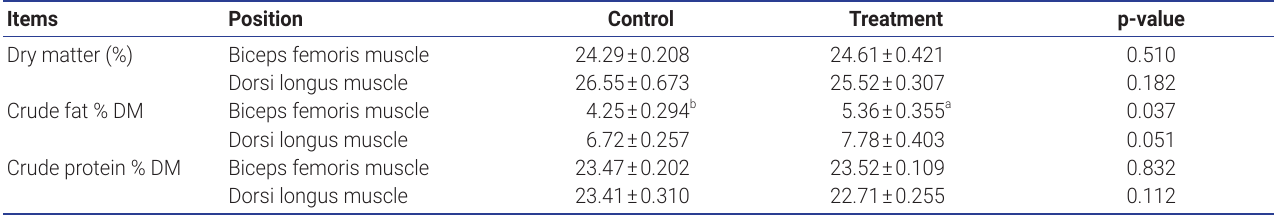
DM, dry matter. Data are expressed as the mean±standard error of the mean (n = 6). a,b Means within a row with common superscripts do not differ